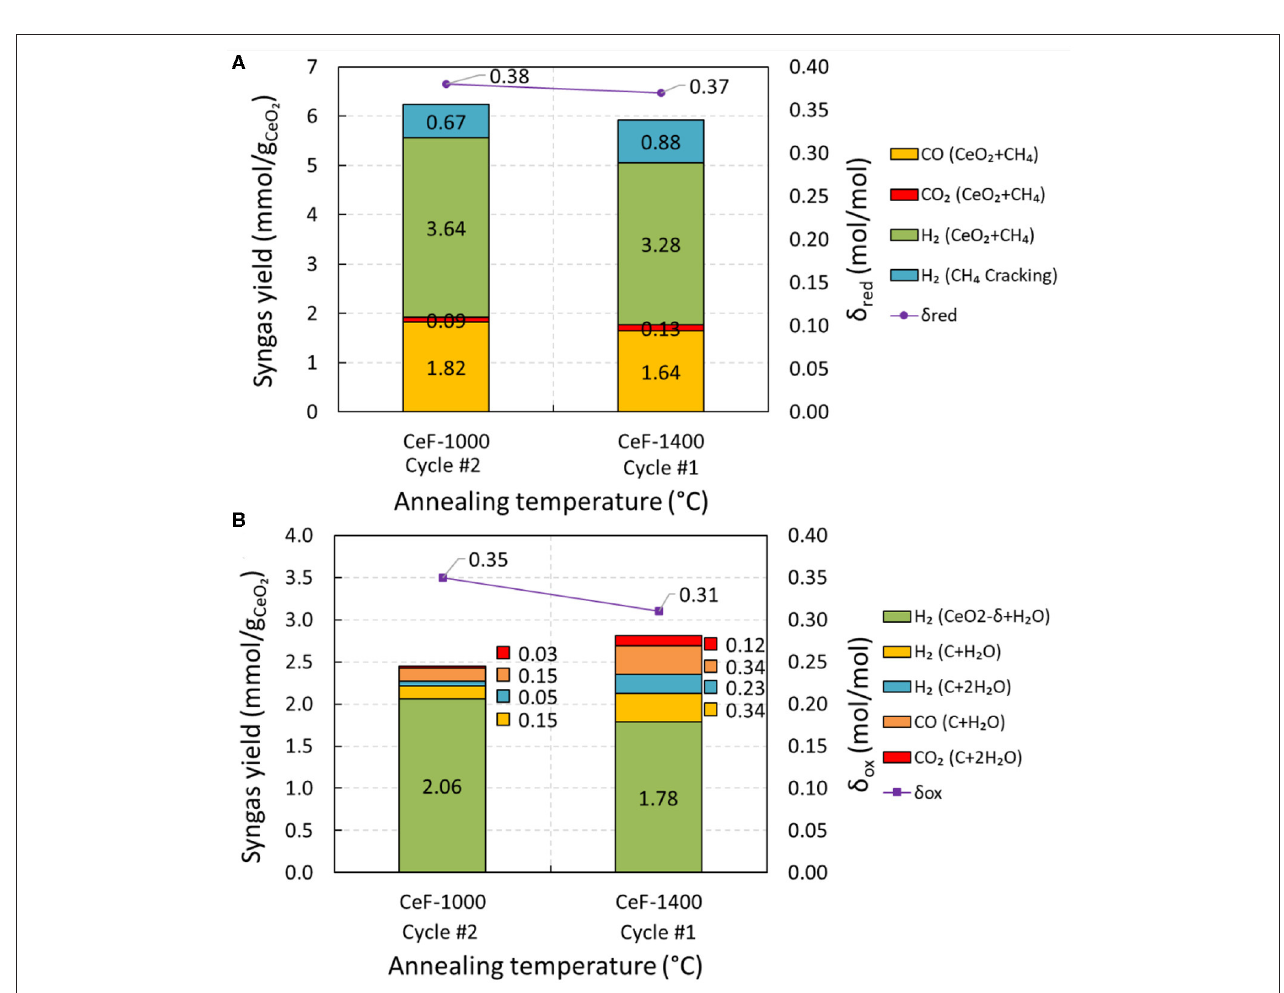
FIGURE 11 | Syngas yield and δ for (A) reduction and (B) oxidation of ceria foams cycled isothermally at 1,000 ◦ C as a function of annealing temperature.